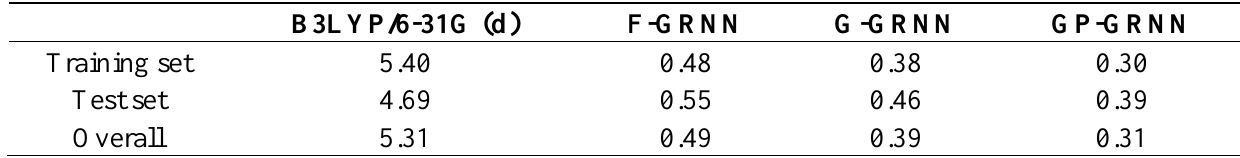
Table 7. RMS of B3LYP/6-31G (d), DFT-F-GRNN, DFT-G-GRNN, and DFT-GP-GRNN correction (in kcal mol − 1